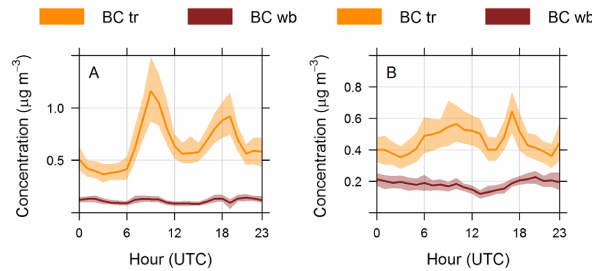
Figure 7. Mean diurnal cycle of concentration of BC wb and BC tr at 880nm during the winter campaign at NK (a) and Detling (b) derived from the aethalometer model. The shaded areas represent the 95% confidence interval. Note the different y axis scales used between panels. Table 5. Percentage contributions of biomass burning and traffic emissions to total EC or BC concentration at 880nm as determined by the tracer method and aethalometer model respectively. Variabil- ity shown is 1 standard deviation. Note NA means not